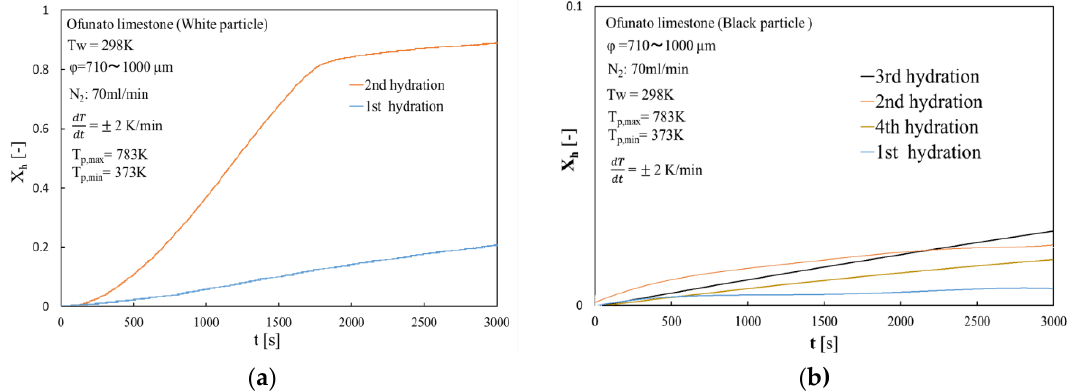
Figure 17. Hydration conversion in TGA-51 system after decarbonization at 1223 K for 5 h in a muffle furnace. ( a ) white particle (Ofunato CaO) ( b ) black particle (Ofunato CaO)